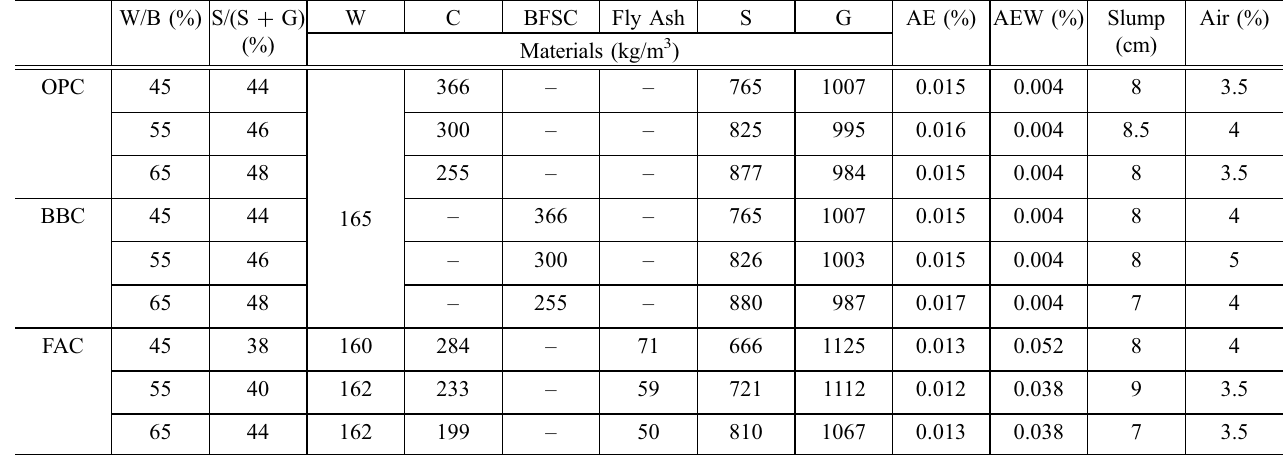
Table 2 Mix proportion of laboratory prepared